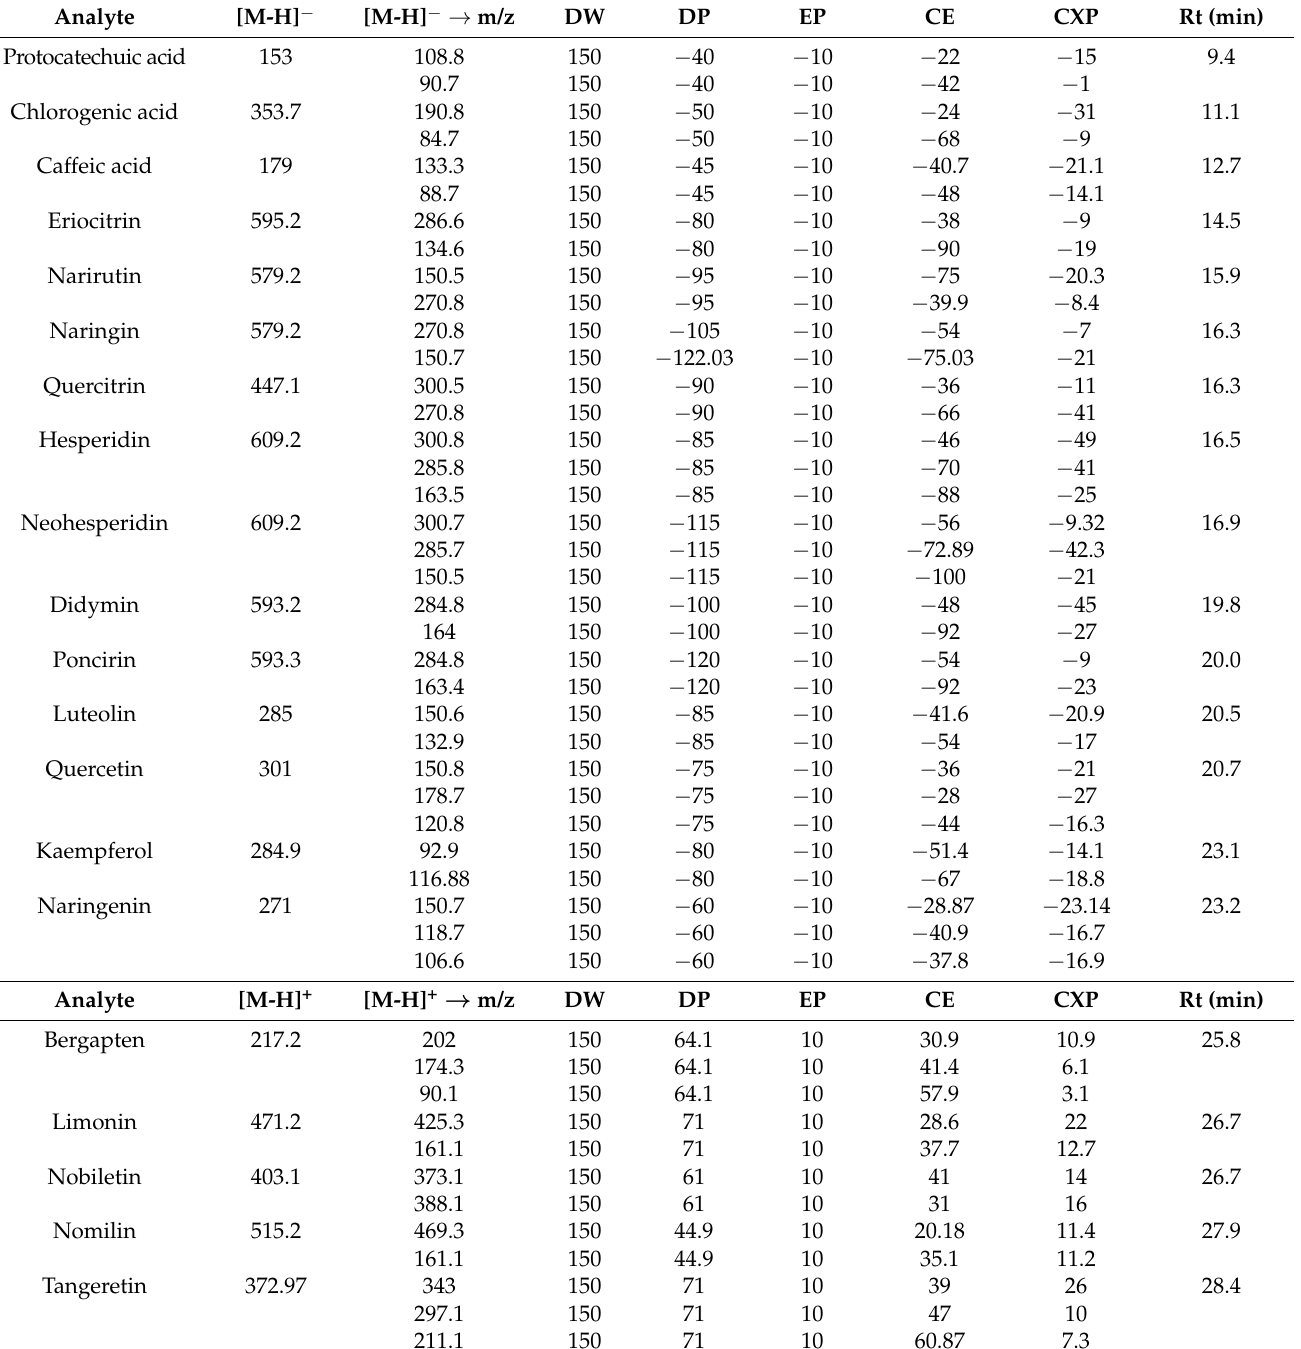
Table 1. Results of optimization parameters for each evaluated